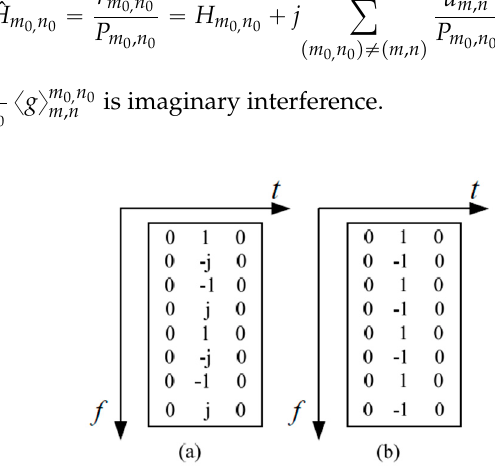
Figure 2. Preamble structures: ( a ) Interference approximation method (IAM); ( b ) Interference cancellation method (ICM).